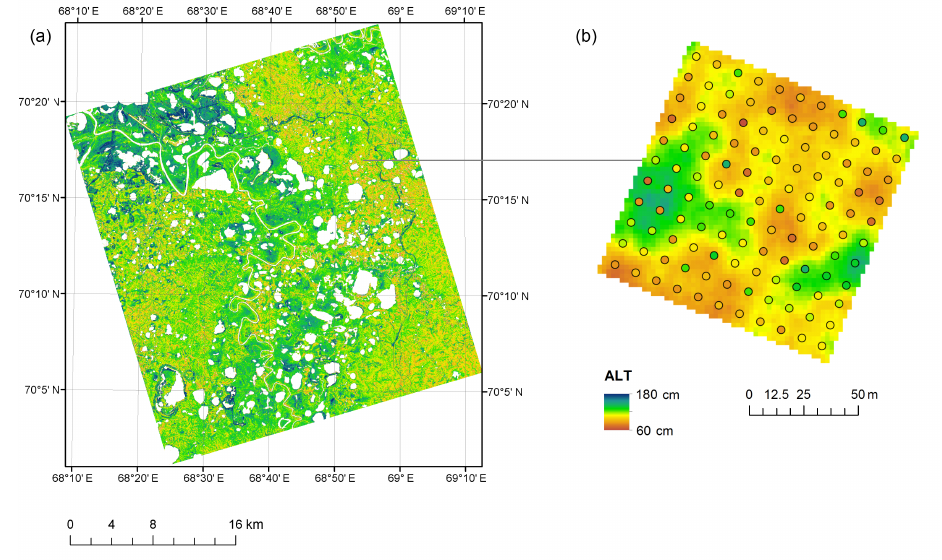
Figure 7. Left: calculated ALT map for all TerraSAR-X scenes, based on TerraSAR-X backscatter values. Right: calculated ALT map (background raster, based on X-band backscatter) for the CALM grid compared to in situ measurements (circles).